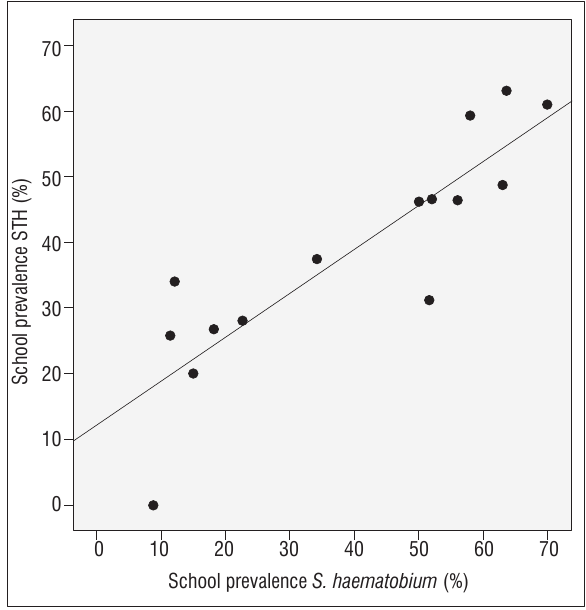
Figure 2: Significant correlation (Spearman’s correlation coefficient =0.93; p <0.001) between prevalence of Schistosoma haematobium and soil-transmitted helminths ( Ascaris lumbricoides and Trichuris trichiura ) in